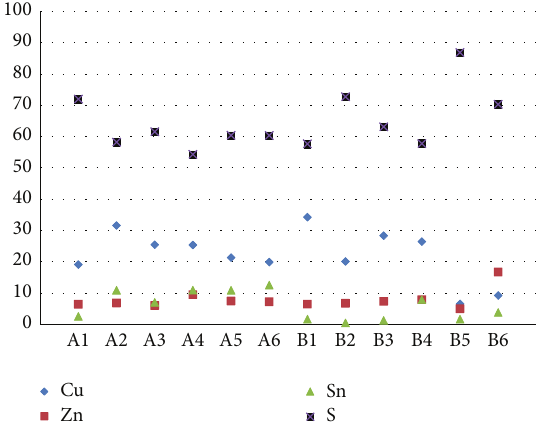
Figure 4: Atomic concentration from energy dispersive X-ray analysis